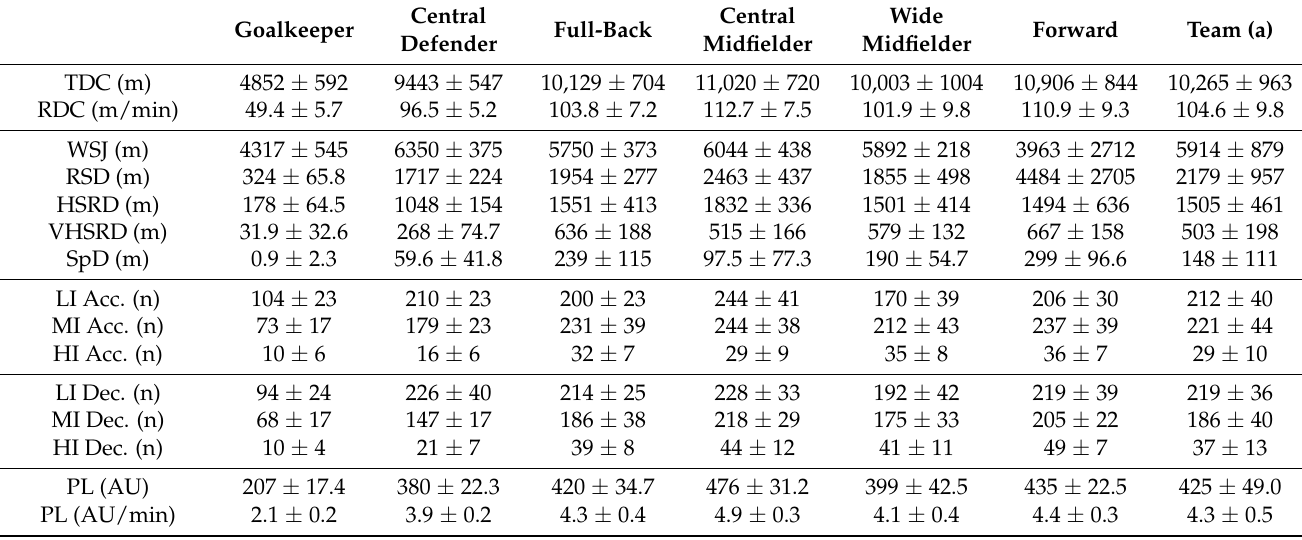
Table 1. External match load by playing position (mean ±